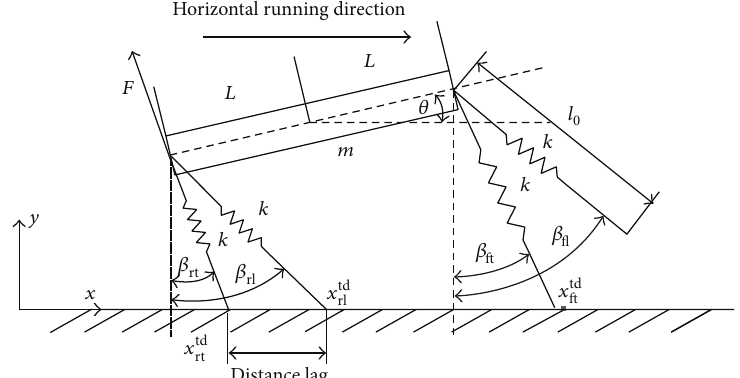
Figure 1: The simplified model for transverse gallop. The topside arrow indicates the direction of running. Each leg is characterized by the stiffness 𝑘 . The uncompressed length of leg is 𝑙 0 . Two legs are attached to the shoulder joint, and the other two are attached to the hip joint. The leg orientation is characterized by 𝛽 . The body orientation is characterized by 𝜃 . The length of the half rigid beam is characterized by 𝐿 . 𝐹 represent the leg force and its orientation coincides with the leg